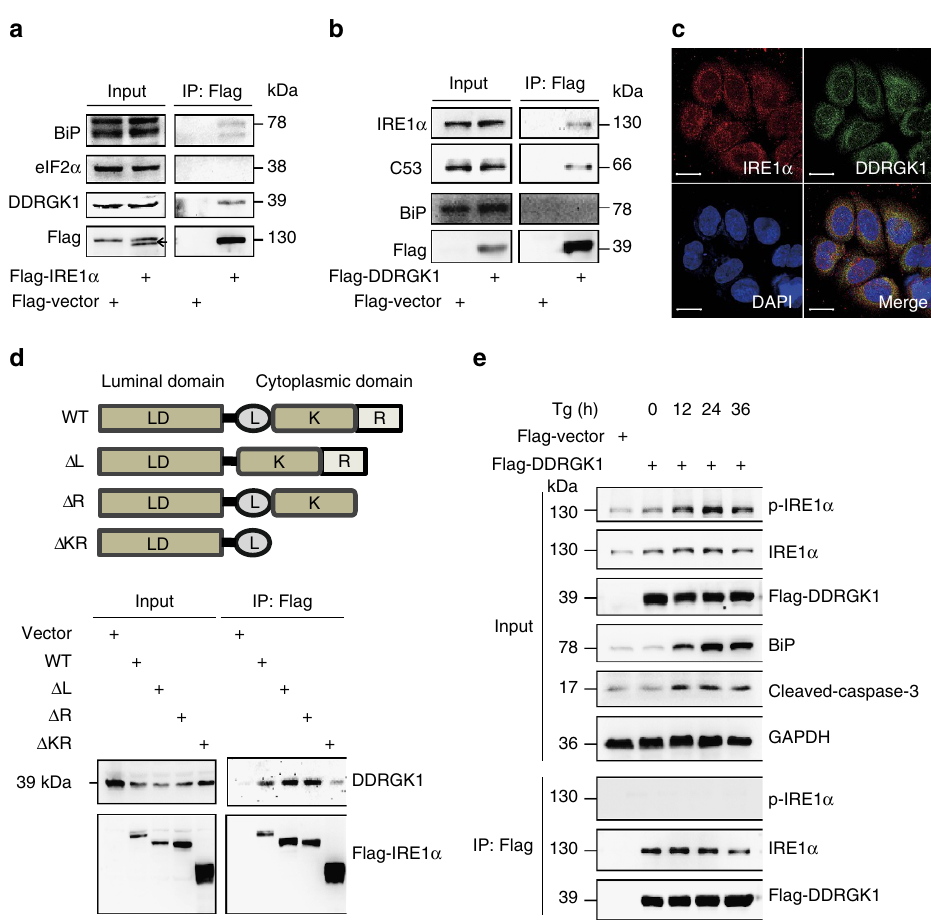
Figure 5 | DDRGK1 interacts with IRE1 a . ( a ). Western blot analysis of immunoprecipitates of Flag M2 affinity gel in HEK293T cells transfected with Flag-Vector or Flag-IRE1 a vectors for 36h. ( b ). Western blot analysis of immunoprecipitates of Flag M2 affinity gel in HEK293T cells transfected with Flag-Vector or Flag-DDRGK1 for 36h. ( c ). MCF7 cells were double immunostained with anti-DDRGK1 antibody (green) and anti-IRE1 a antibody (red). The cell nuclei were counterstained with DAPI (blue). The co-localization between the two endogenous proteins DDRGK1 and IRE1 a is shown in the merge panel. Scale bar, 20 m m. ( d ) Schematics of IRE1 a wild-type and truncated constructs and western blot analysis of the Flag M2 affinity gel immunoprecipitates in HEK293Tcells transfected with Flag-Vector or Flag-IRE1 a wild-type and truncates. ( e ) Western blot analysis of Flag M2 affinity gel immunoprecipitates in mock-or Tg-treated (2.5 m M) HEK293T cells expressing Flag-Vector or